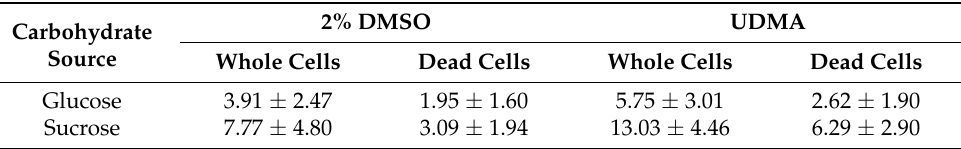
Table 1. Biovolumes ( µ m 3 / µ m 2 ) of the biofilms of S. mutans UA159 formed on saliva-coated surfaces in the presence and absence of UDMA, as assayed using a LIVE-or-DIE TM viability/cytotoxicity kit. DMSO was used as a vehicle for UDMA, and cells grown without UDMA (2% DMSO) were used as the control. The biovolume was calculated based on five randomly selected areas of each biofilm after 24 h biofilm